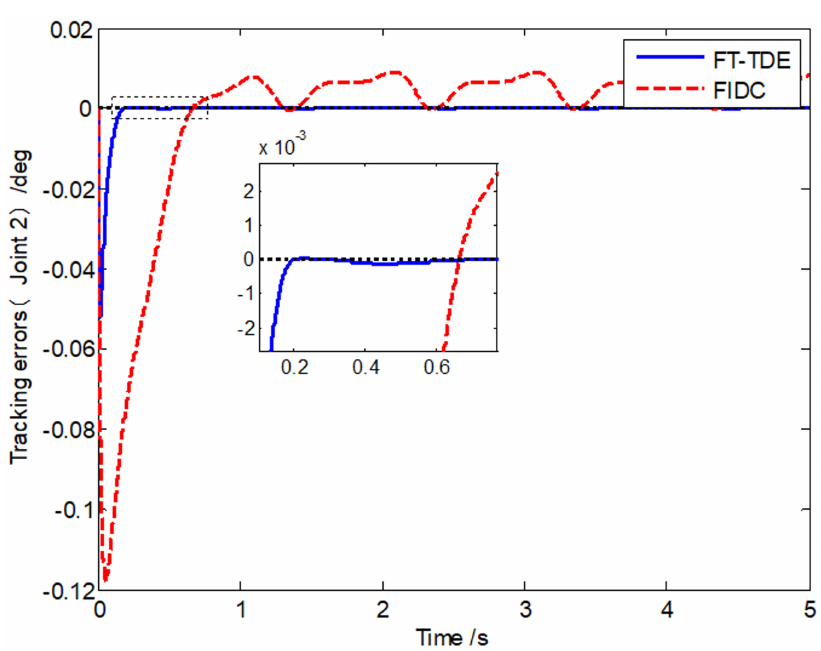
Figure 2. Tracking errors of Joint